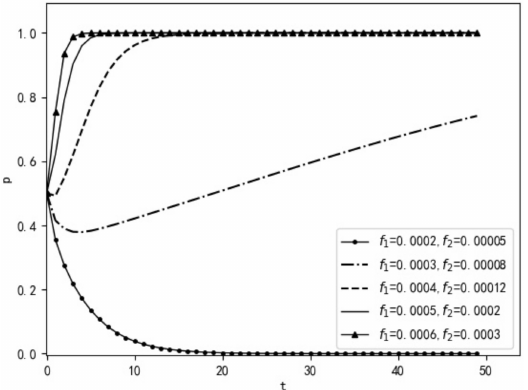
Figure 10. The impact of unit reputation loss on sewage discharge